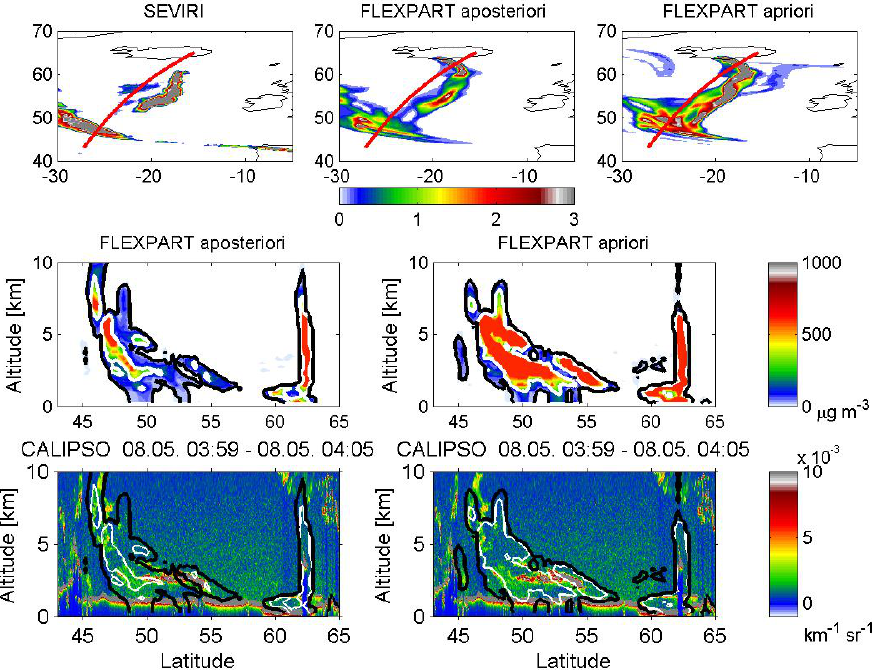
Fig. A1. Comparison between satellite-retrieved and modeled ash on 8 May at 04:00UTC. Top row: Ash total columns retrieved from geosynchronous satellite observations between 04:00–05:00UTC (left panel) and a posteriori (middle panel) and a priori (right panel) mod- eled ash total columns. The red line shows the track of CALIPSO overflying the ash plume. Middle row: Vertical cross-sections through the a posteriori (left panel) and a priori (right panel) modeled ash concentrations. Bottom row: Vertical cross-section along the red line shown in top panels of total attenuated backscatter at a wavelength of 532nm obtained from CALIPSO (colored) superimposed with 20µgm − 3 (black line) and 200µgm − 3 (white line) isolines of modeled volcanic ash concentrations. The left panel shows the a posteriori, the right panel shows the a priori model results. Notice that many features seen in the CALIPSO data (e.g., the extensive layer near 1km altitude) are water or ice clouds, not ash.